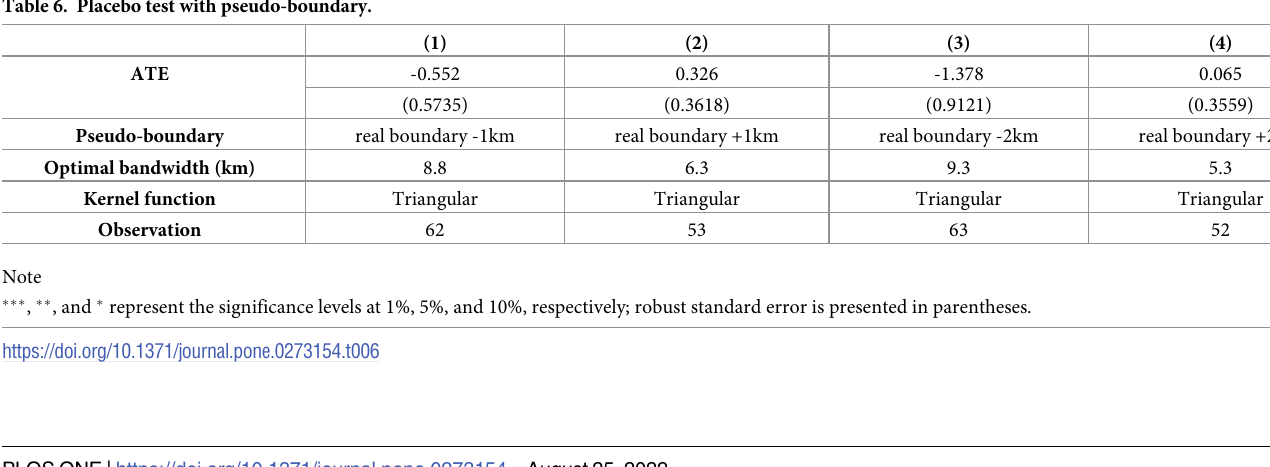
control variables at the cutoff are insignificant. Therefore, there is no empirical evidence that